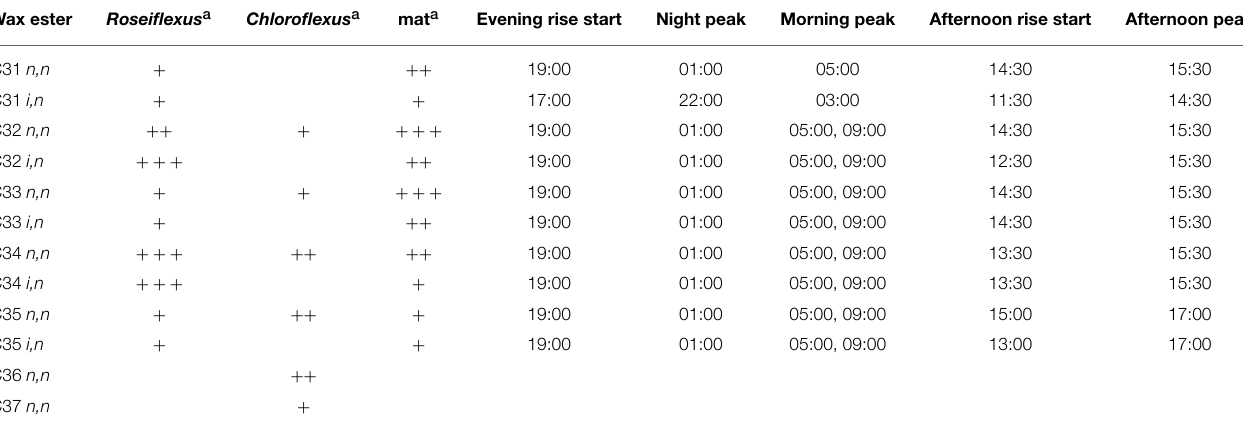
TABLE 3 | Wax ester content of mat and Chloroflexi and timing of abundance changes in the mat. Wax